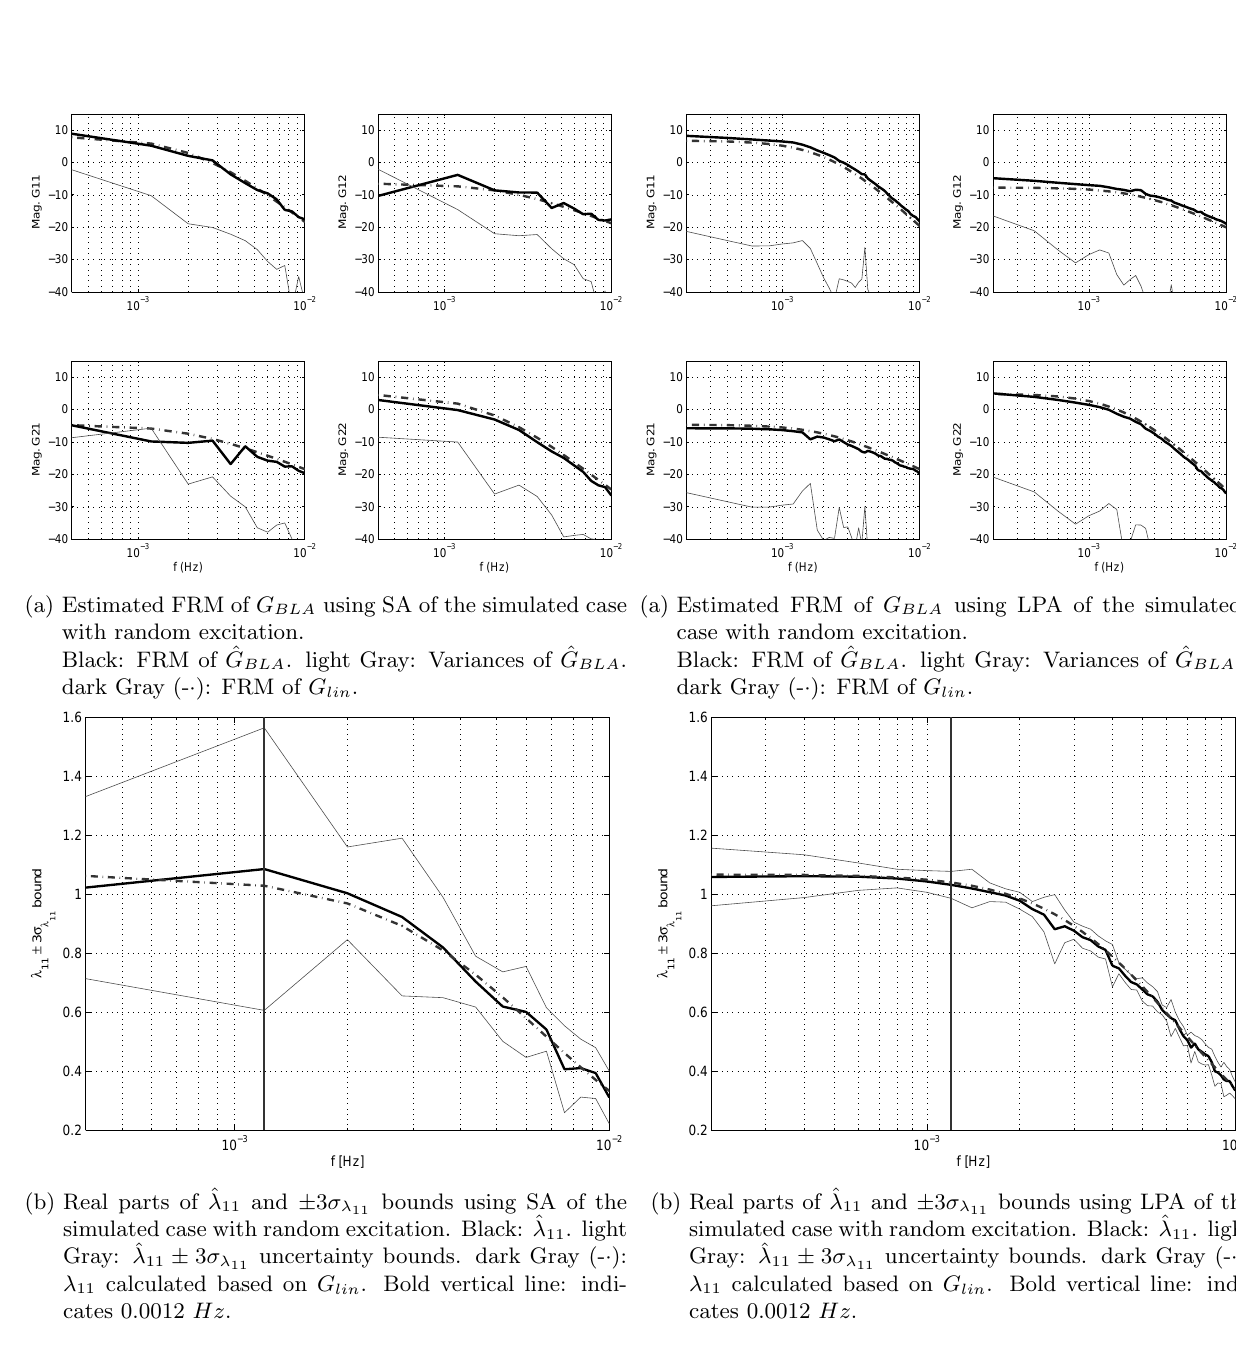
Figure 4: Simulation results of ˆ G BLA and ˆ λ 11 using SA method.